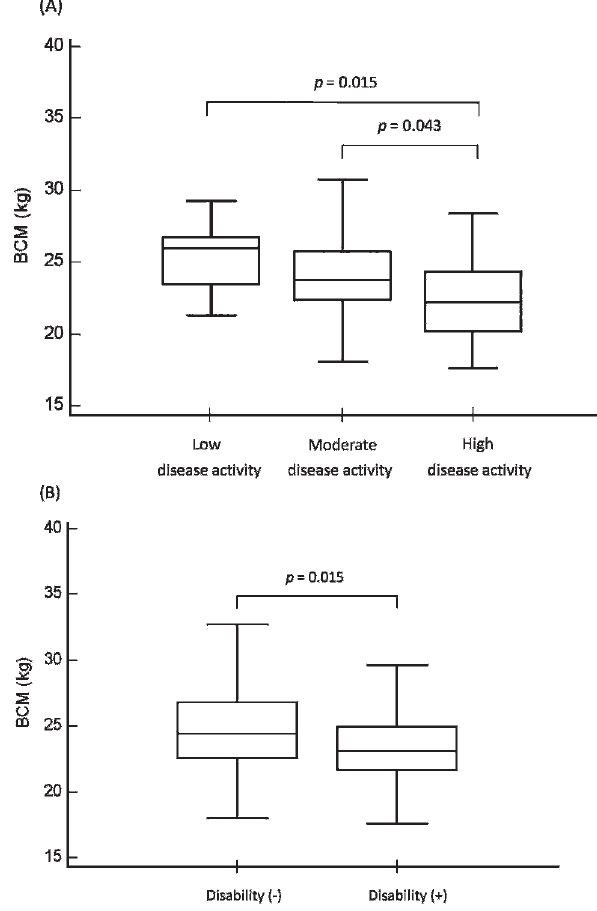
Figure 2 - (A) Comparisons of body cell mass (BCM) values of RA patients with low, moderate and high levels of disease activity by analysis of variance. (B) Comparisons of BCM values of RA patients with and without disability by independent sample t- test. Values are presented as box-plot diagrams, with the box encompassing the range from the 25 th percentile (lower bar) to the 75 th percentile (upper bar). The horizontal line within the box indicates the median value, and the horizontal lines above and below the box represent the maximum and minimum values, respectively, for